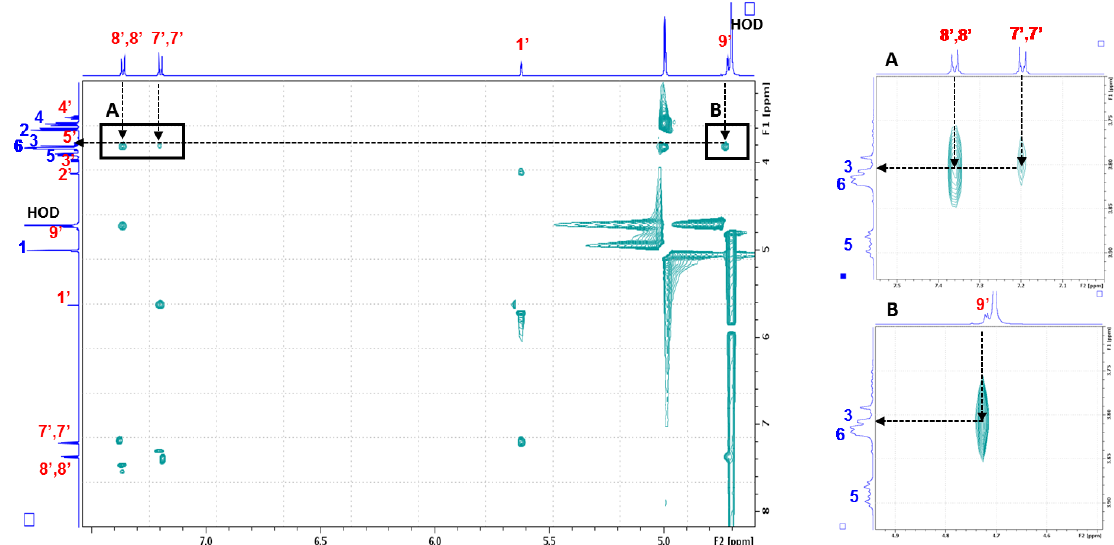
Figure 10. Partial contour plot of transverse rotating-frame Overhauser enhancement spectroscopy (T-ROESY) experiment (spin lock field strength 1250 Hz, 600 MHz, D 2 O, 300 K) performed on 5 mM equimolar α-CD/MOR mixture with expansion ( A , B ) of intermolecular cross-peaks between MOR and α-CD.